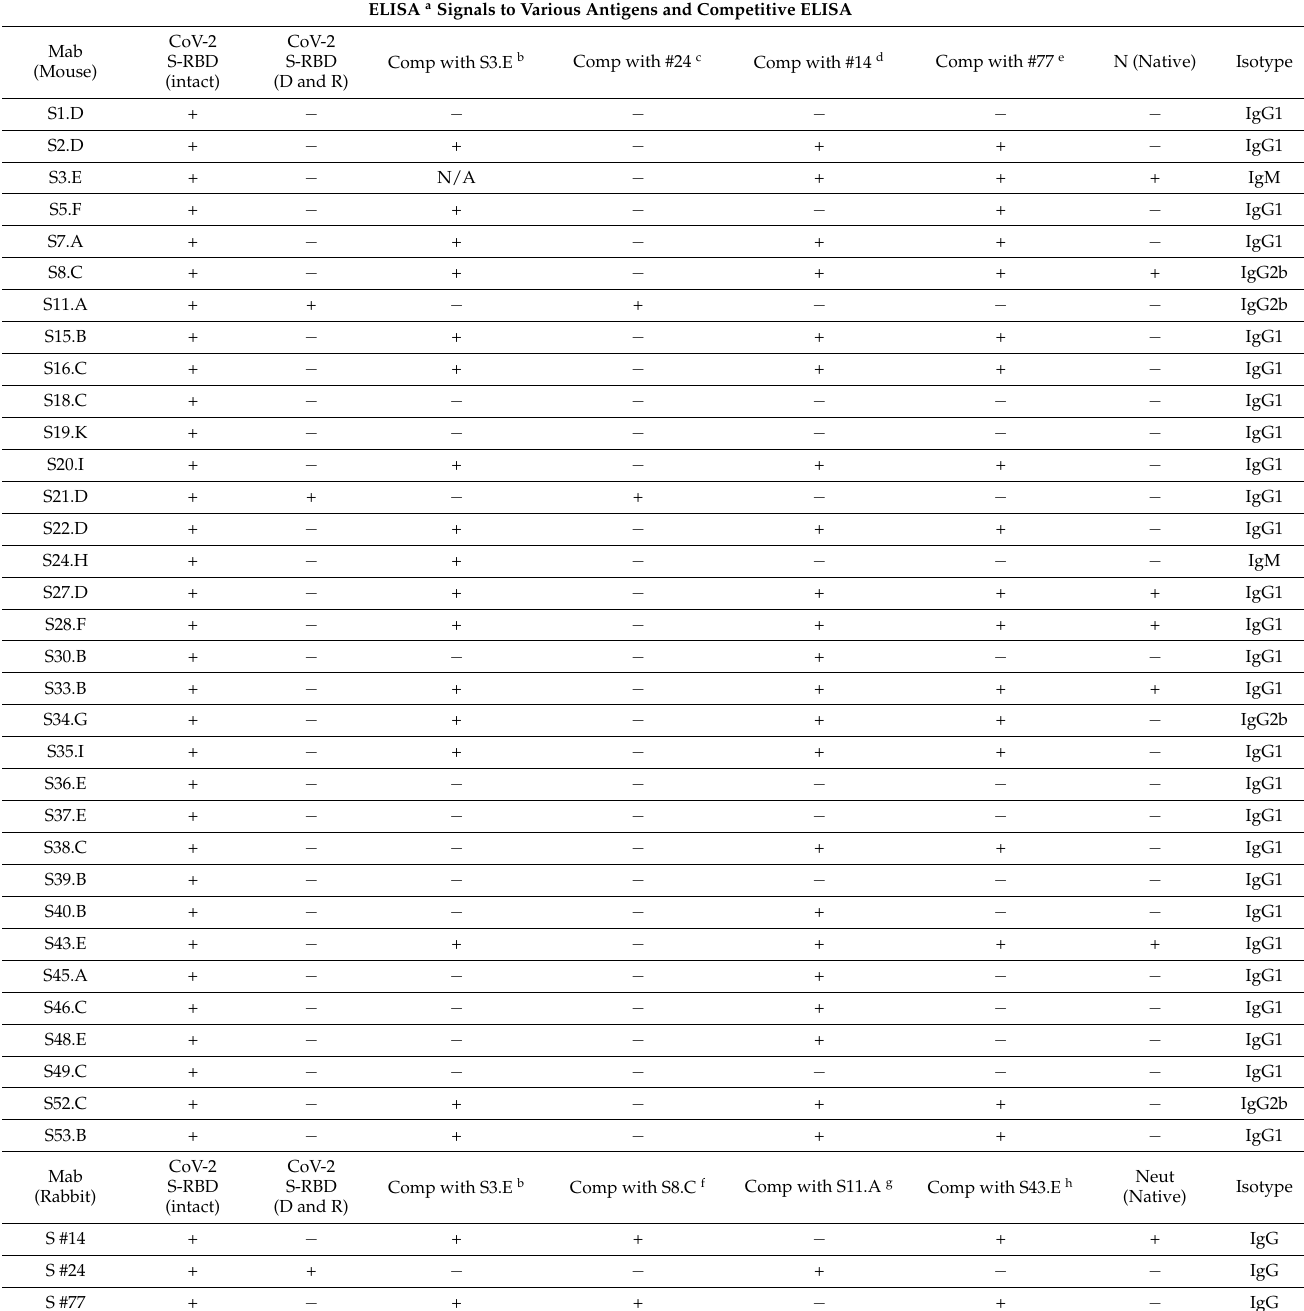
Table 1. Reactivities of anti-S-RBD monoclonal